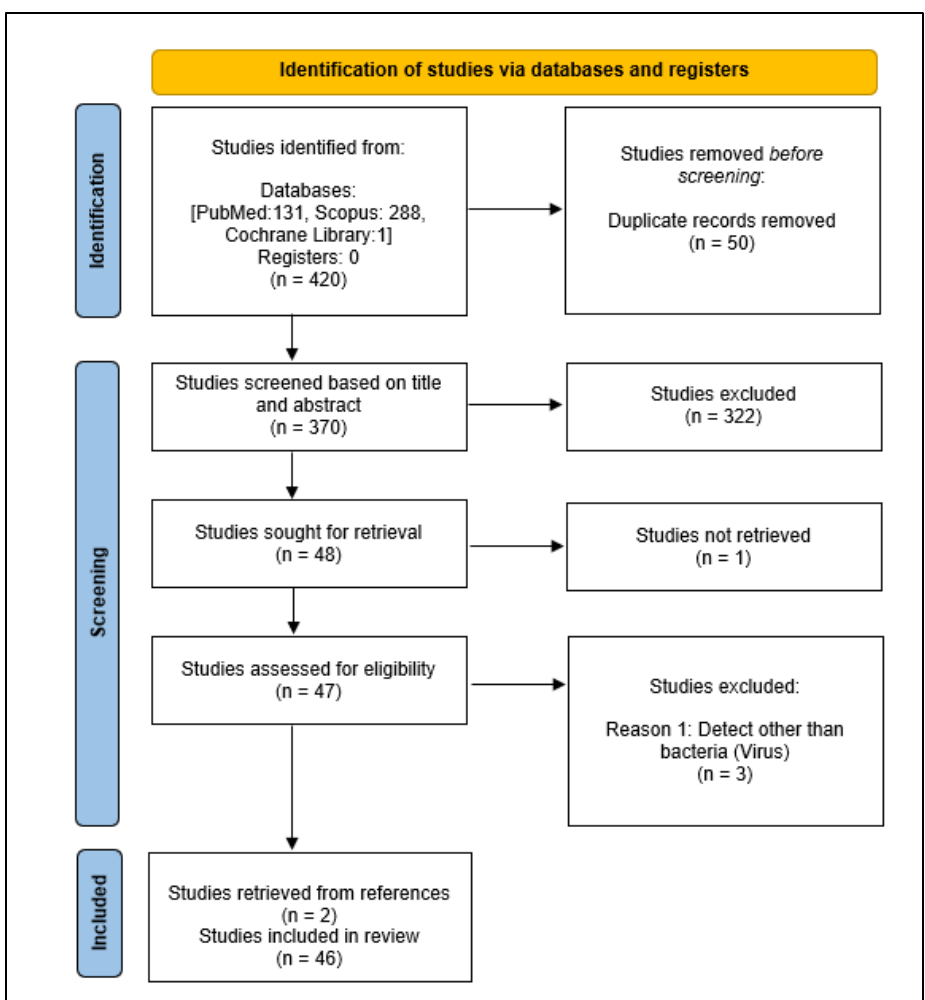
Diagnostics 2022 , 12 , x FOR PEER REVIEW 11 of 21